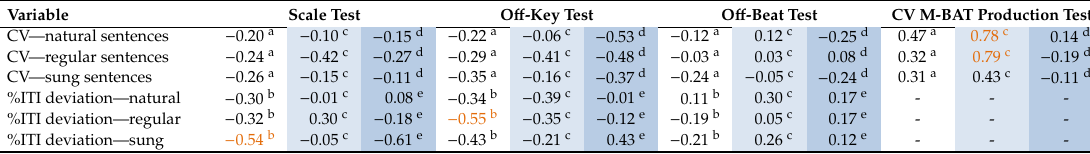
Table 6. Spearman correlations between tapping and music